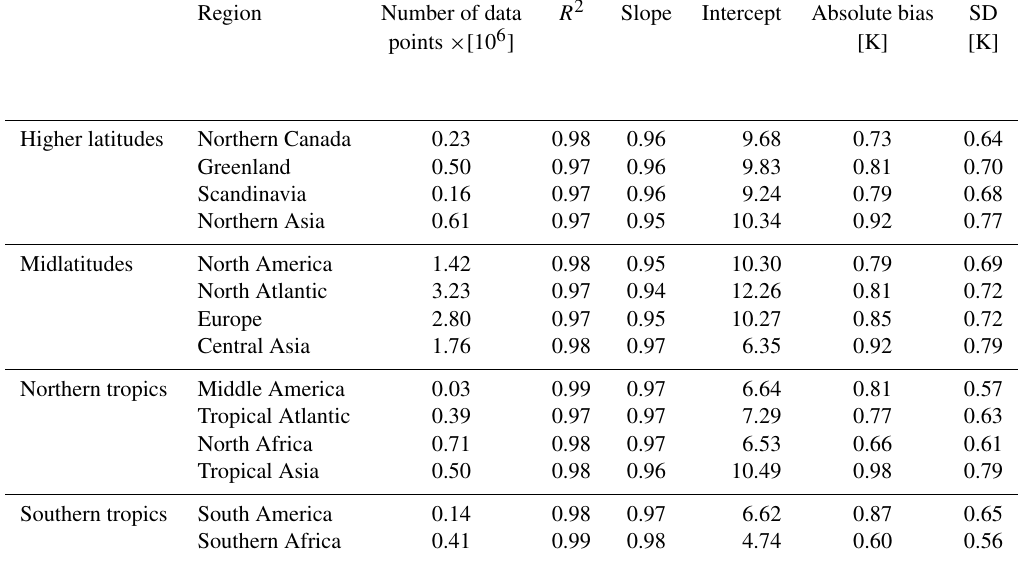
Table 2. Statistical parameters summarized for all regions studied (see Fig. 9). The slopes and intercepts are determined from the linear robust regression fit between ERA-I and IAGOS temperature. Additionally, for each region the absolute bias and its SD are given.